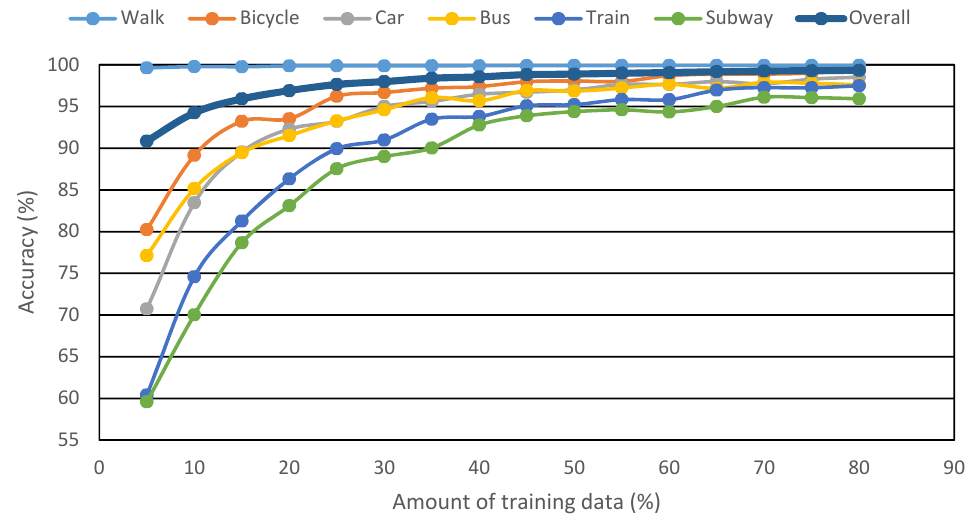
Figure 11. Change in classification accuracy with amount of training data. Table 5. Percentage of learning data used by various researchers.